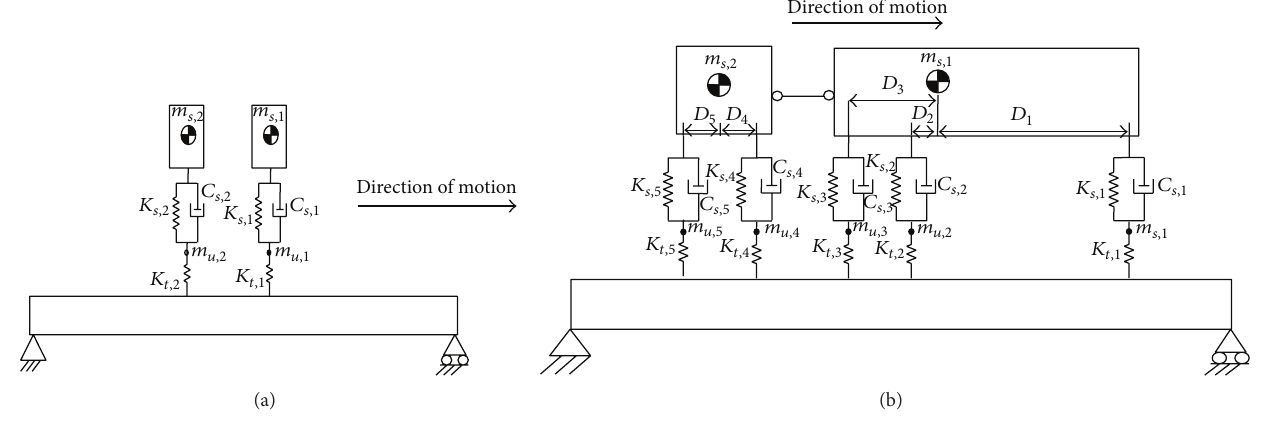
Figure 8: (a) Two identical quarter-cars, (b) truck-trailer model, after